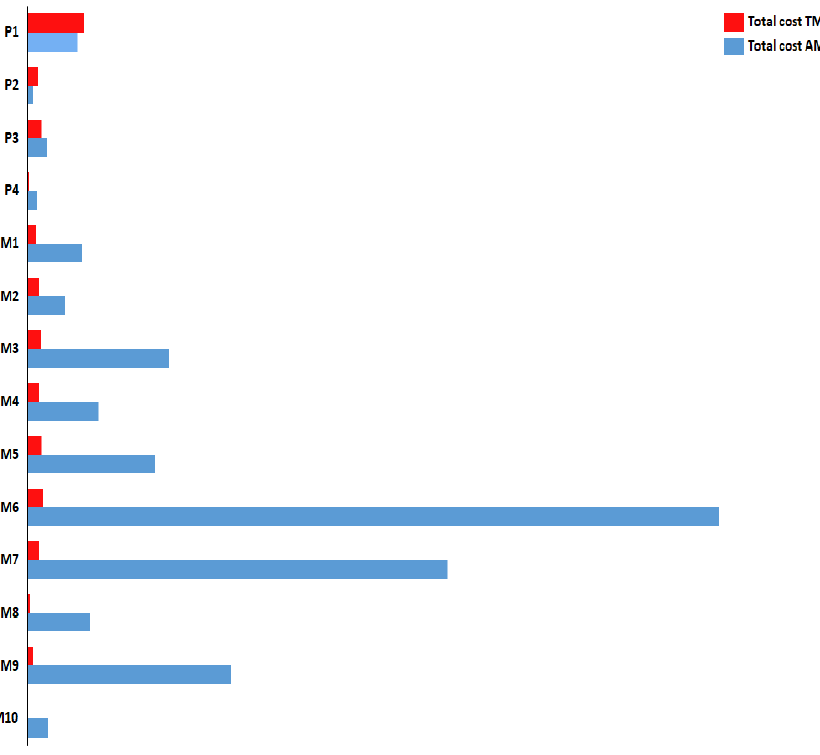
Figure 3. Comparison of total costs between AM and TM for individual spare parts. The AM process technologies used for these 14 parts are presented in Table 6. Table 6. The AM process technologies and raw material used for the 14 case study parts. Item No.